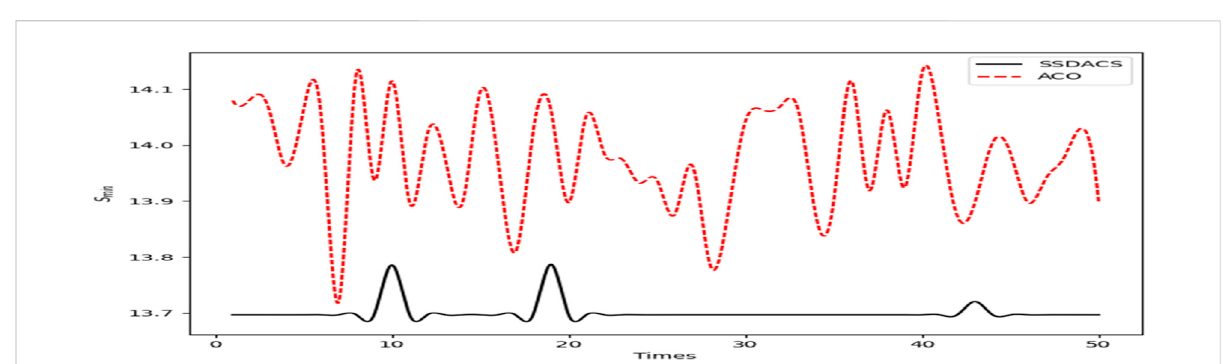
FIGURE 11 The comparison of S min 50 times between DSSACS and